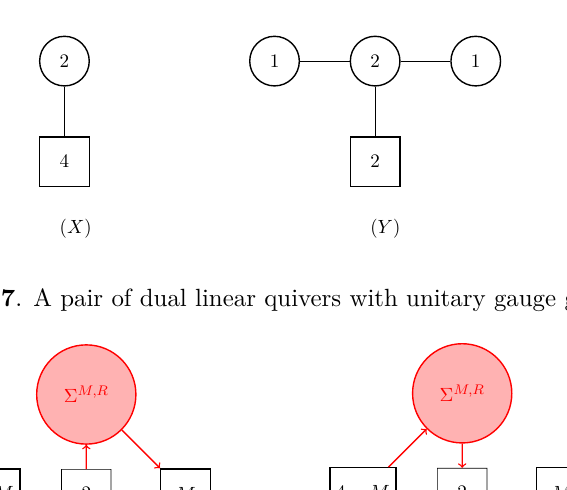
Figure 26 . A 3d mirror pair involving a D 4 quiver gauge theory and an SU (2) gauge theory with four flavors.